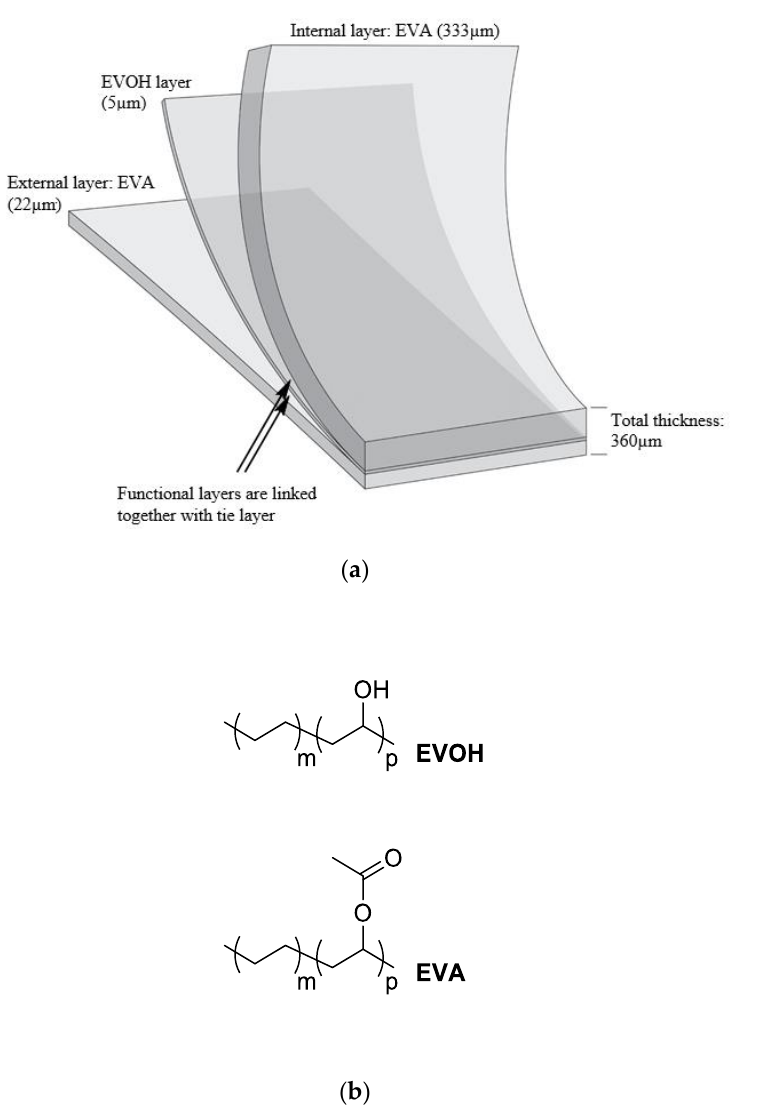
Figure 1. Structure of EVA multi-layer film ( a ) and structure of polymers ( b ). Reproduced from [34] with the permission of European Journal of Pharmaceutical Sciences.